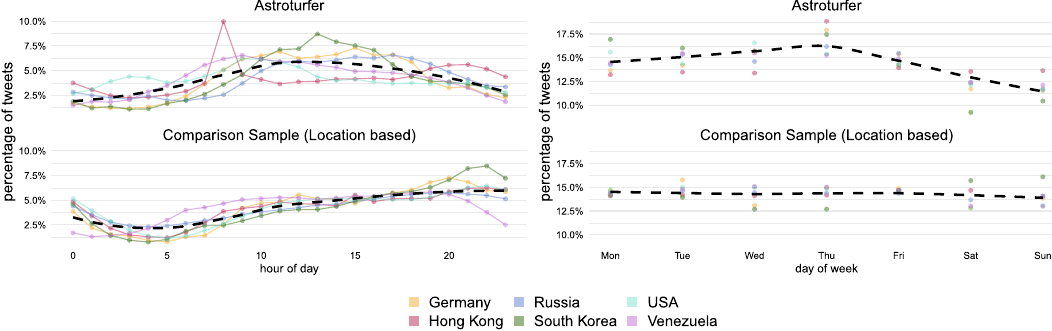
Figure 2. Astroturfing campaigns are most active during office hours and working days. Comparison of hourly (left) and weekly (right) activity of astroturfing campaigns and location-based case-specific random samples. Dashed line indicates the average